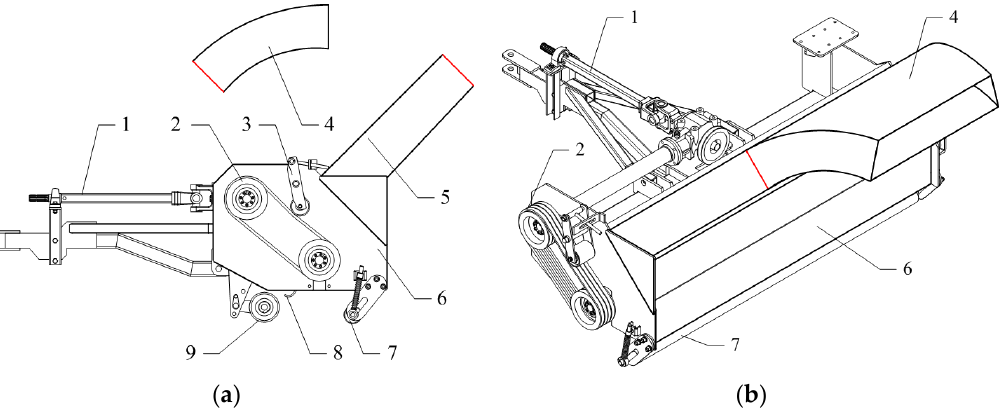
Figure 1. Structure diagram of the 4JMLE-210 agricultural residual film recycling machine. 1. Drive shaft 2. Straw-crushing and throwing unit 3. Straw-conveying unit 4. Residual film winding-up unit 5. Residual film picking-up unit 6. Hydraulic drive the walking wheels. ( a ) Structure diagram. ( b ) Picture of real products.